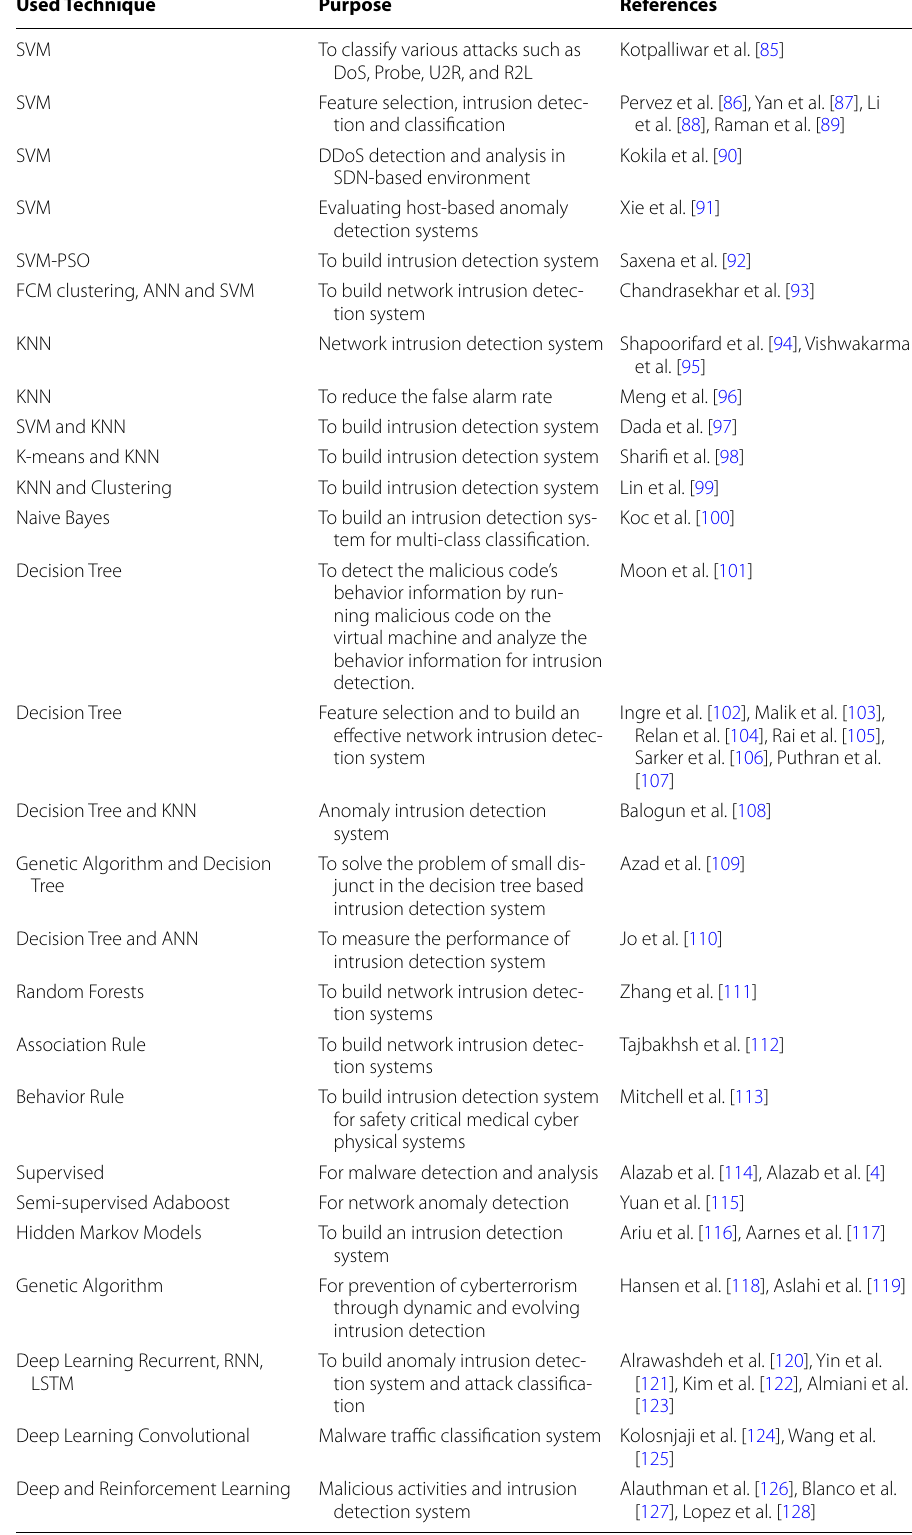
Table 4 A summary of machine learning tasks in the domain of cybersecurity Used